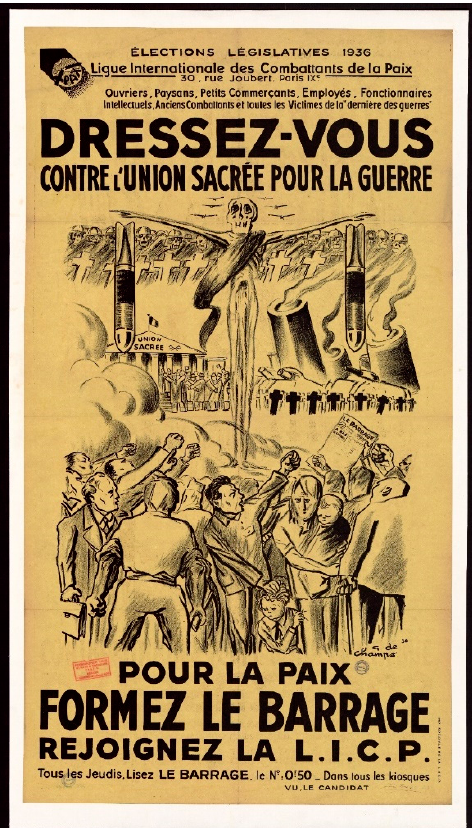
Figure 11. “Stand Up Against the Sacred Union for War. For Peace. Form the Dam. Join the L.I.C.P.” Ligue internationale des combattants de la paix. 1936. Ink on paper. La Contemporaine. AFF20566.